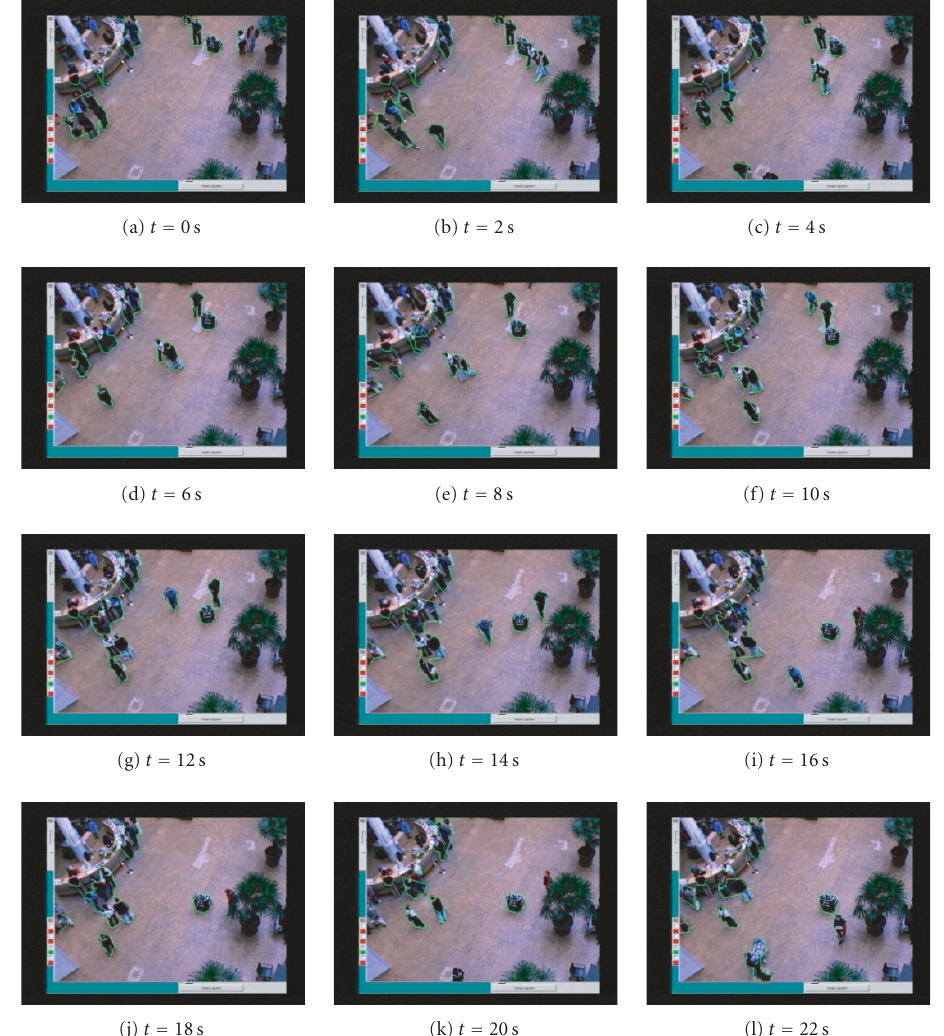
Figure 7: Object detection and contour polygons.